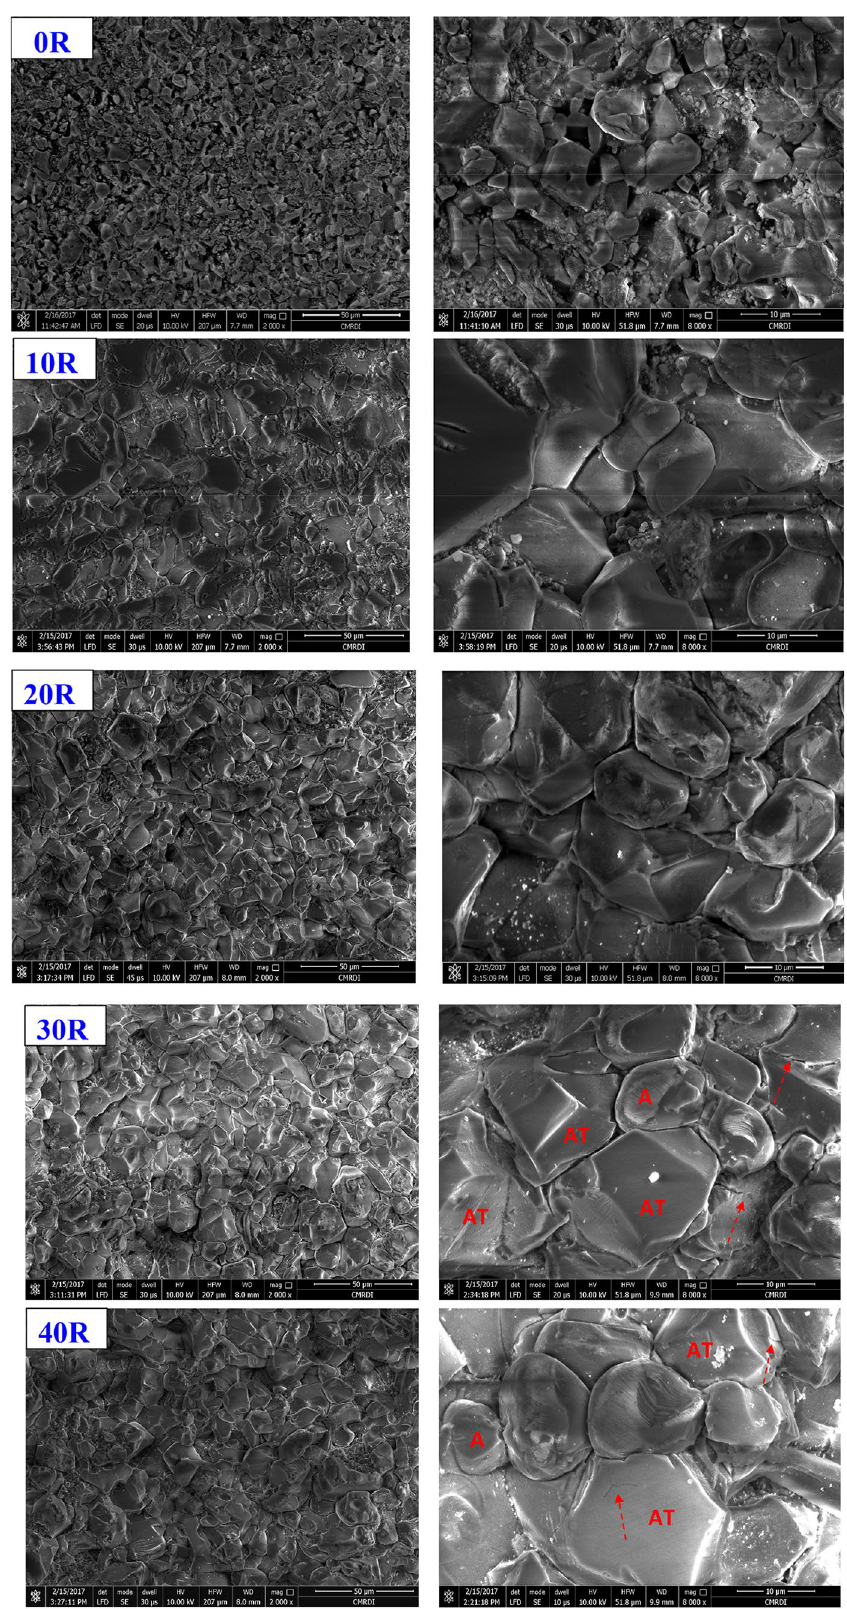
Figure 5. FE-SEM micrographs of the sintered A/AT composites with different rutile content (0–40